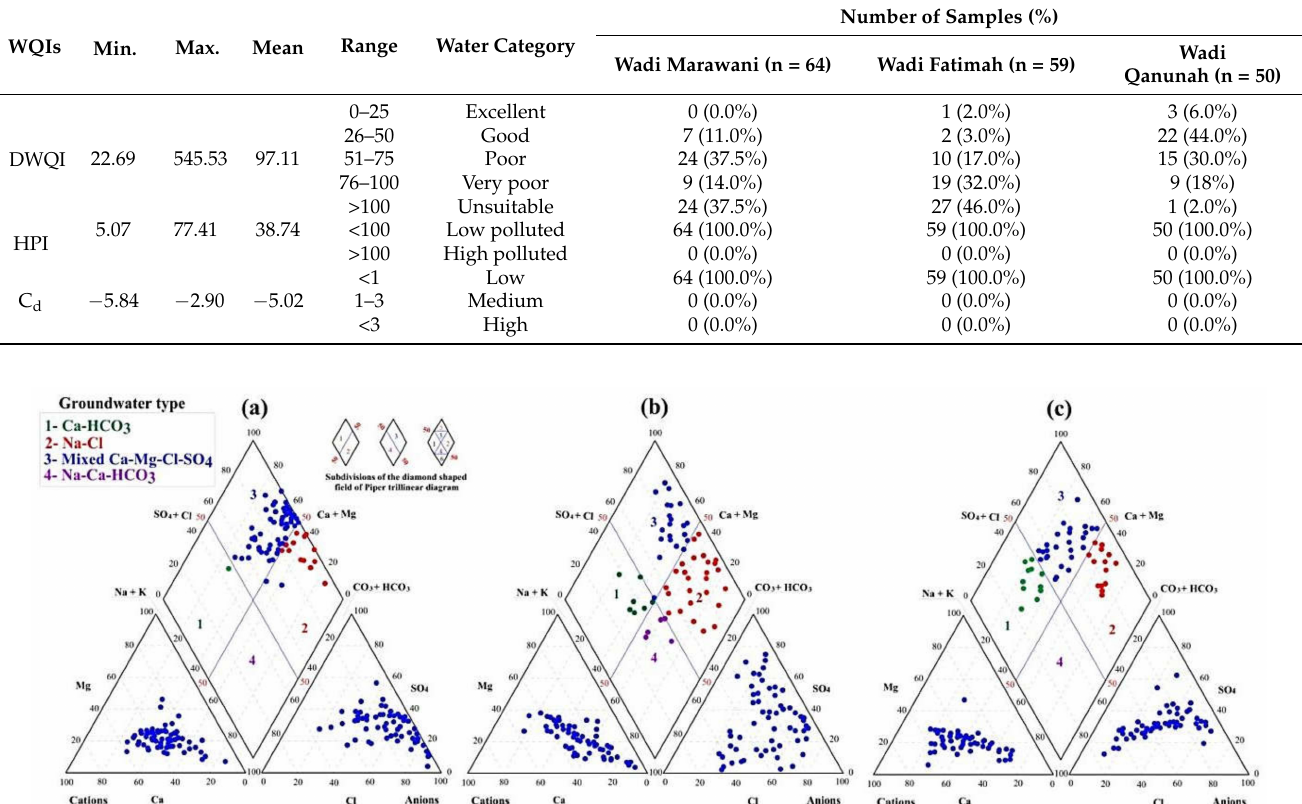
Table 6. Classification of several water quality indices (WQIs).